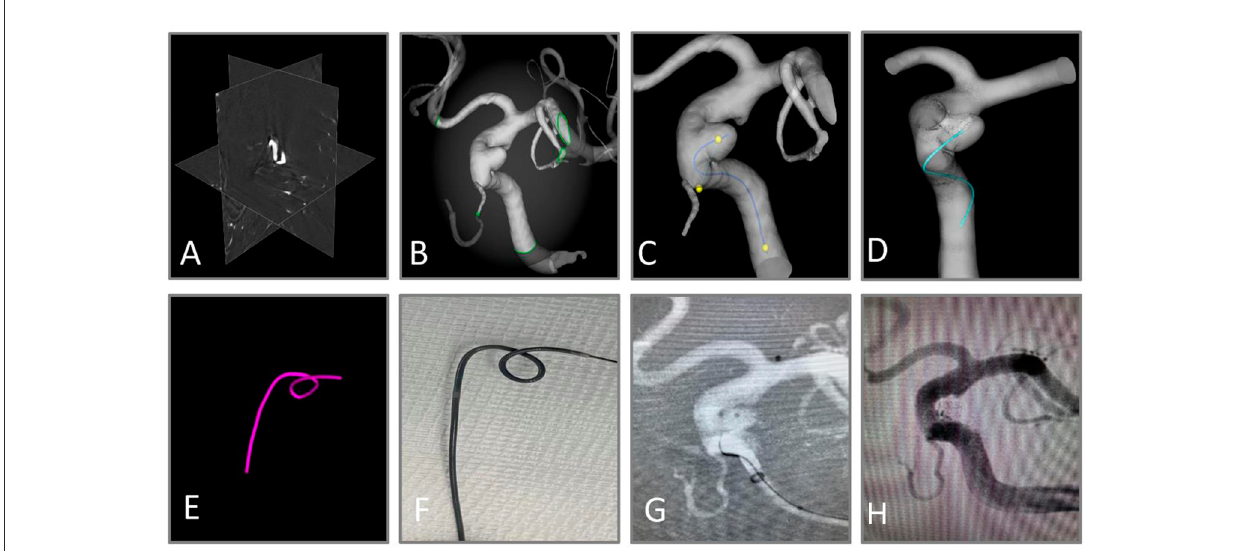
FIGURE1 Workflow of virtual shaping of microcatheter with AneuShape TM . (A) Reading of 3D RA images. (B) Segmentation and reconstruction of intracranial vessels. (C) Generation of the centerline, and the picking of three key points. (D, E) Visualization of anticipated microcatheter after removal of the mandrel (cyan) and that with mandrel inserted after shaping (purple). (F) The microcatheter was shaped manually using a template generated by the software. (G) The aneurysm sac was successfully catheterized through the shaped microcatheter. (H) Satisfactory aneurysm